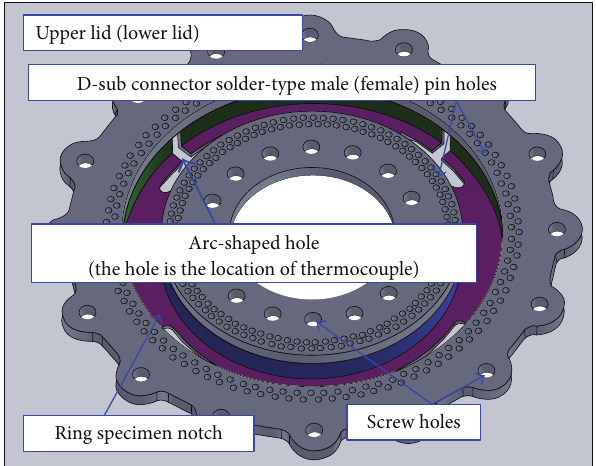
Figure 6: Structure of upper lid (level 1) and lower lid (level